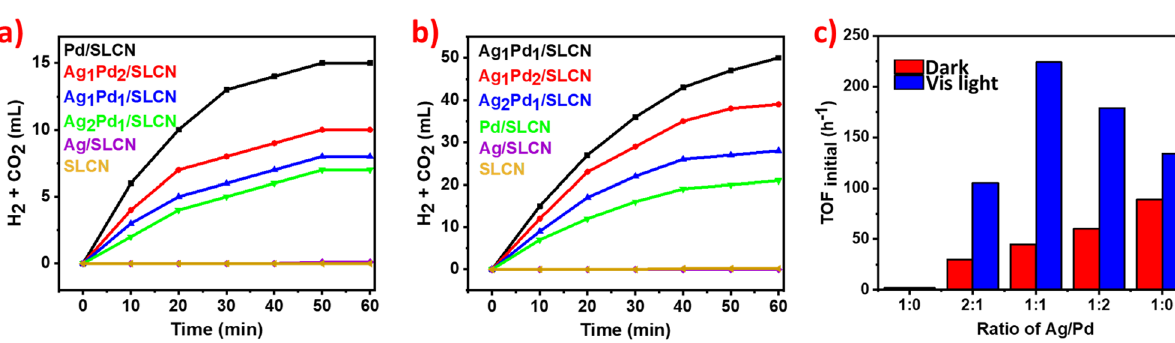
Figure 7. ( a ) Time-dependent gas evolution plots from FA in the dark at ~ 30 °C, ( b ) in the light irradiation at ~ 30 °C and ( c ) the TOFs ratio of various catalysts in the dark and light